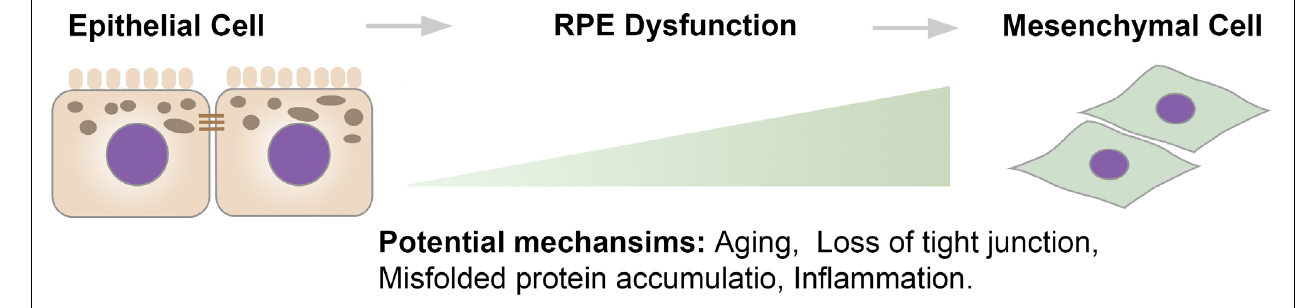
FIGURE 1 | The epithelium to mesenchyme continuum. There is a continuum between epithelial cells and mesenchymal cells. Across the continuum, the transition starts from well-differentiated RPE cells that exhibit barrier integrity and cellular polarity to intermediate stages, where RPE cells become dedifferentiated and lose functions, to mesenchymal-like cells that exhibit an increased proliferative rate and migrate into the neuroretina.